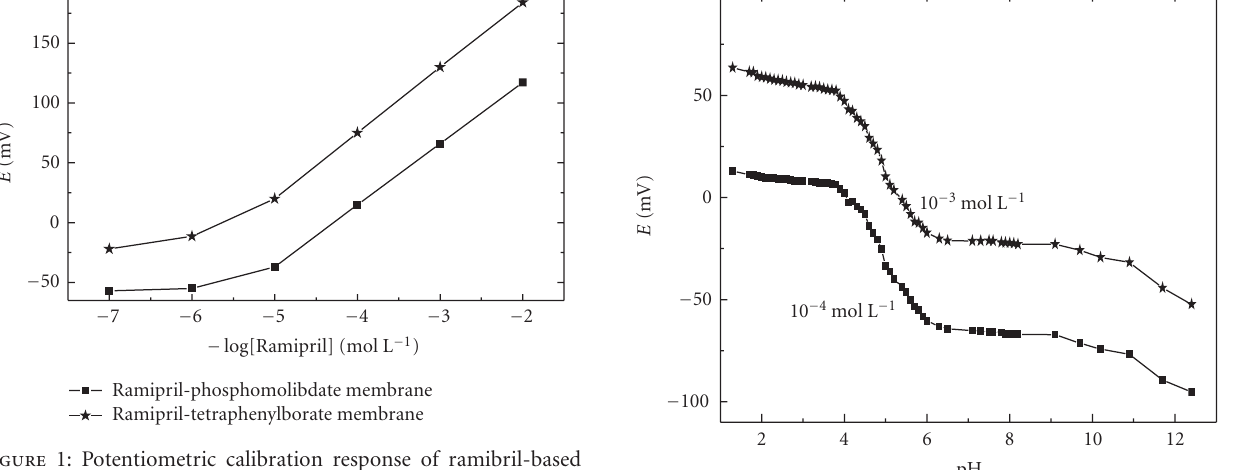
Figure 1: Potentiometric calibration response of ramibril-based selective electrodes.